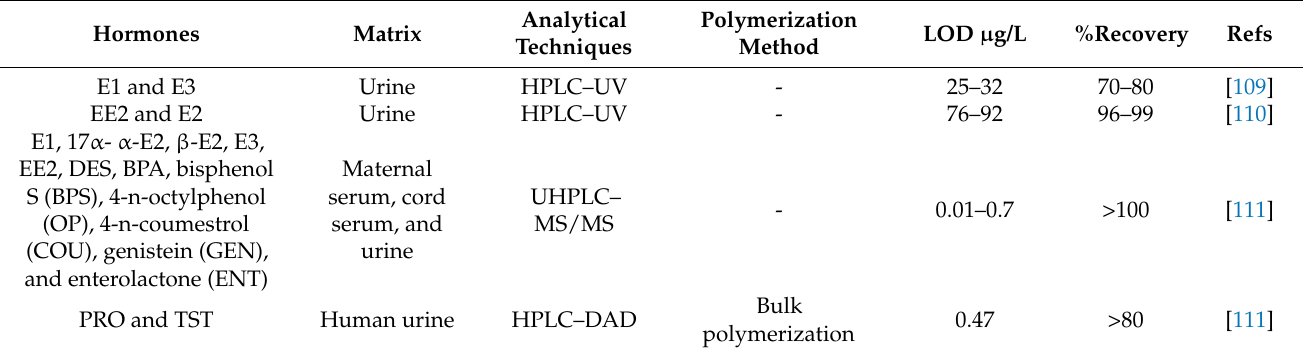
Table 4. Summary of application of MIPs for the determination of hormones in biological